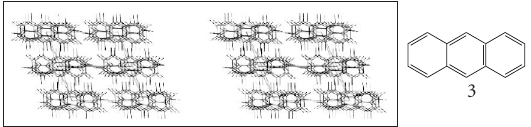
Figure 3: Stereoscopic view of the molecular packing of anthracene 3 with (110) on top, showing that both the 9- and 10-positions are only available from the front (or the back); the left side is unreactive